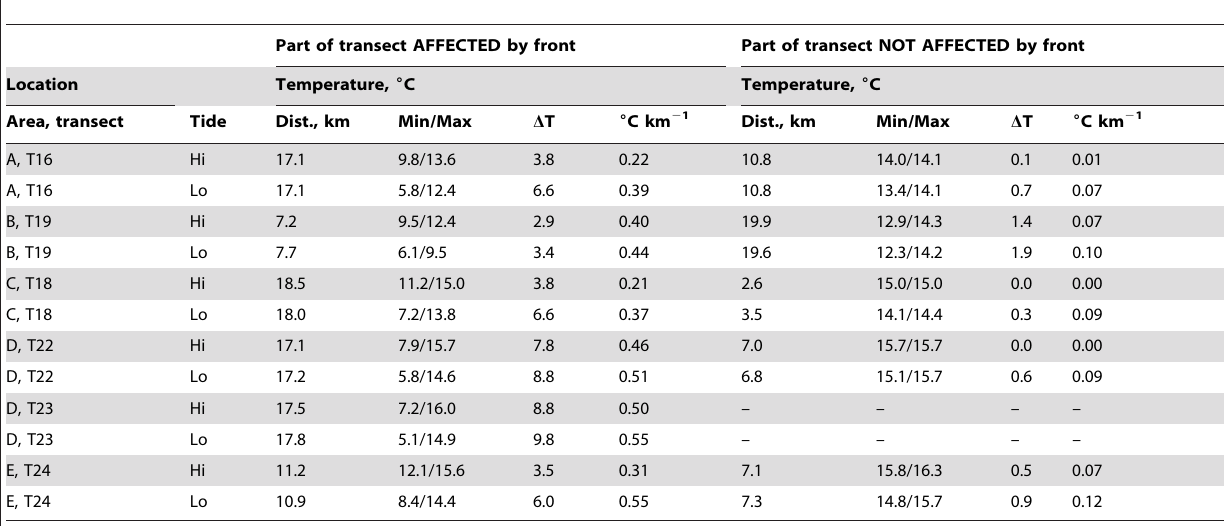
Table 2. Comparison of parts of seabed transects along which temperature is affected or not affected by the tidal front at high and low tide.